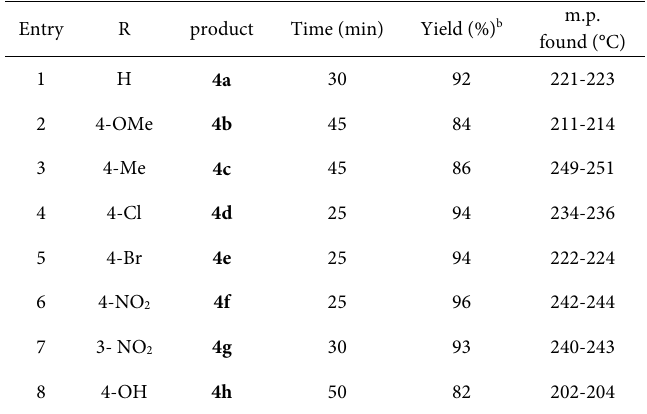
Table 3. Synthesis of indenopyrazolones